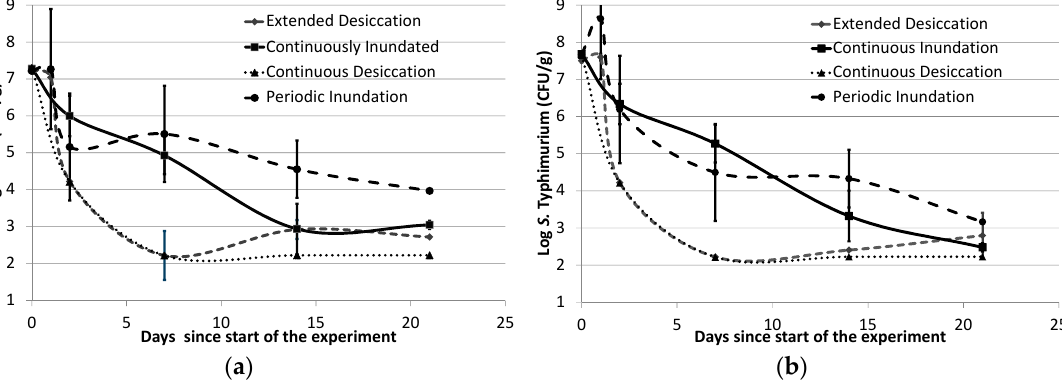
Figure 3. Survival of the test organisms; ( a ) E. coli K1 densities (cfu/g dw) and ( b ) S. Typhimurium NVSL 6993 densities (cfu/g dw) in the four experimental configurations (error bars represent standard deviations around the mean values of the replicates tested).